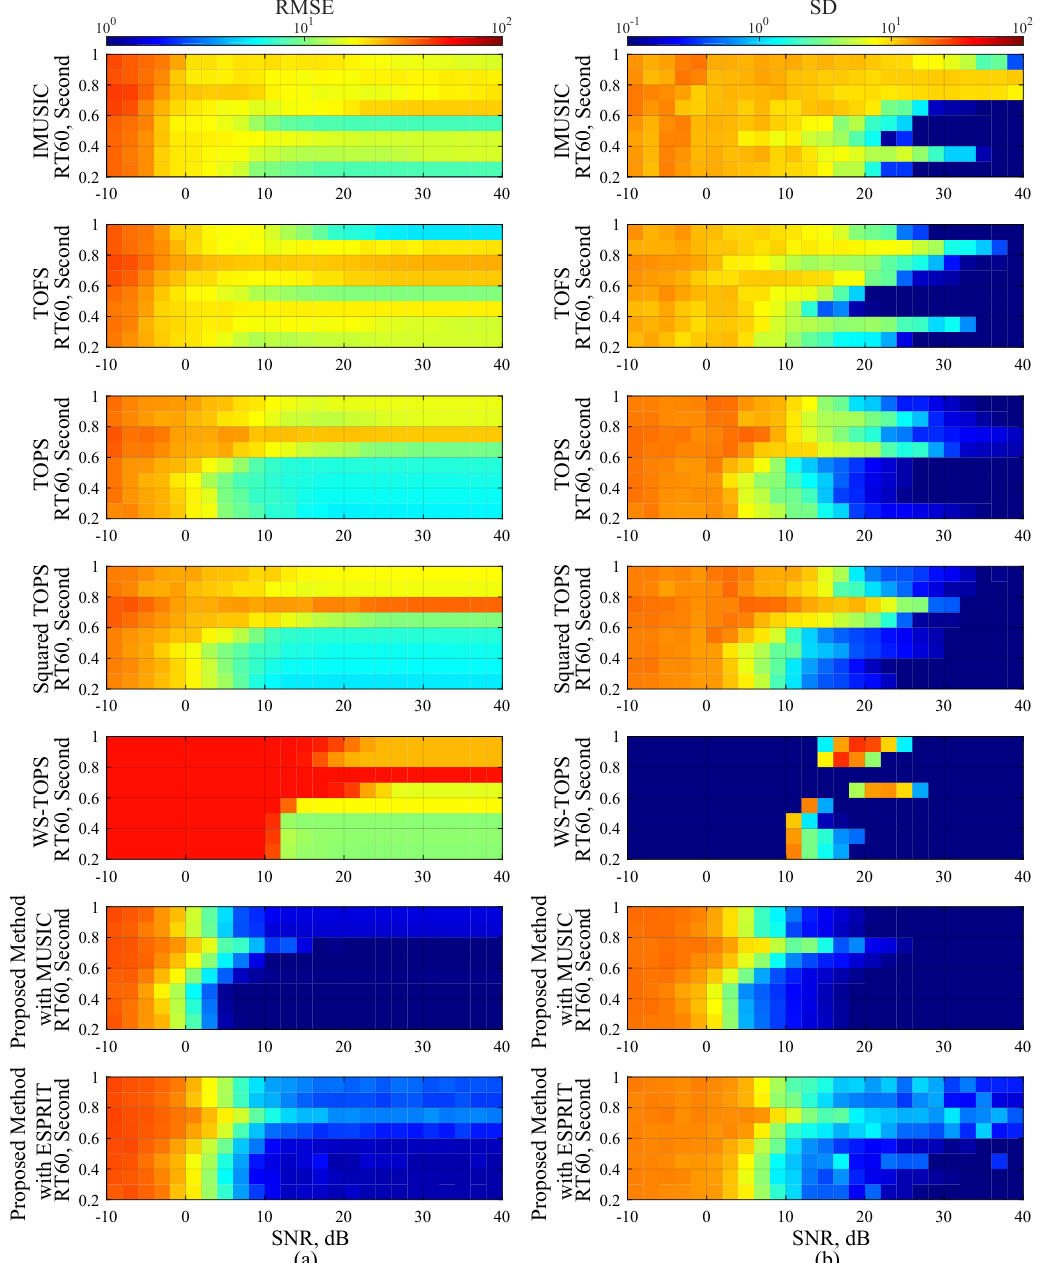
Figure 8. Performance evaluations of Scenario 4; ( a ) RMSE estimation performance versus SNR, and ( b ) SD estimation performance versus SNR, where three uncorrelated human speeches are employed along with a reverberant environment. The reverberations were simulated by the following procedure [53], where dimensions of enclosure room is 15 × 15 × 5 m, a measurement protocol of reverberation time is RT60, and wall absorption coefficients are followed on Table